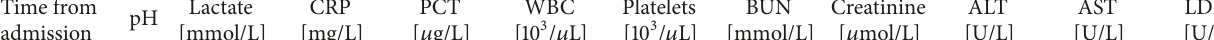
Table 1: Laboratory parameters during the course of multiple immune-modulatory therapies including CVVHD + CytoSorb. Time from